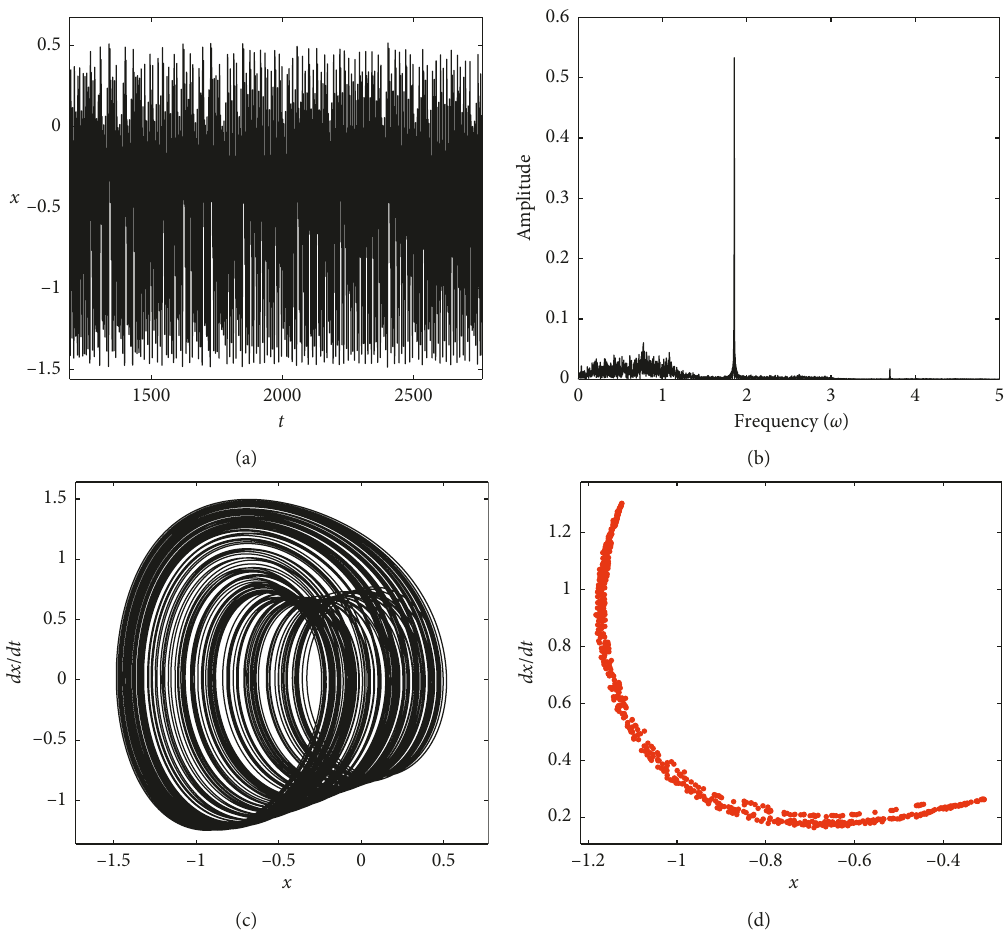
Figure 13: System response at ω � 1.85rad/s and F � 1.75N: (a) time history; (b) frequency spectrogram; (c) phase portrait; (d) Poincare